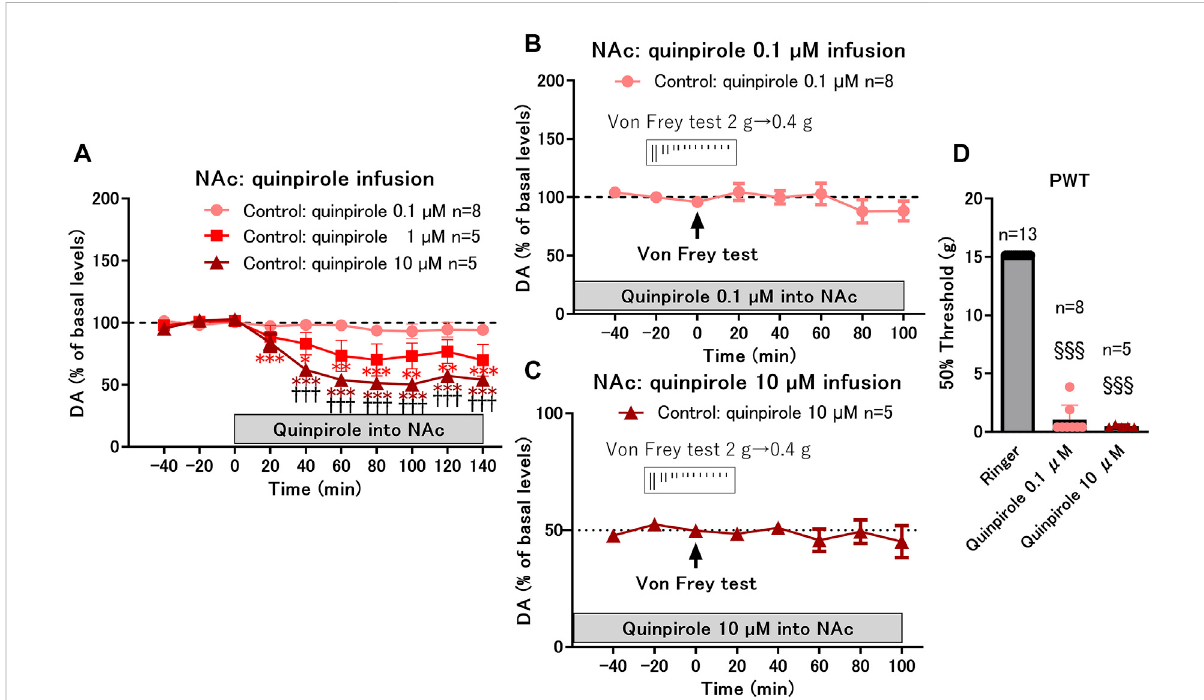
FIGURE 4 Effects of local infusion of quinpirole into the nucleus accumbens shell (NAcSh) on the paw withdrawal threshold (PWT) in control rats. (A) EffectsoflocalinfusionofaD2-likereceptoragonist,quinpirole,intotheNAcSh(0.1,1,and10 μ M)onthebasallevelsofDAinthecontrolgroup;* p < 0.05, ** p < 0.01, *** p < 0.001 versusthe basal levels ofDA inthesame group; mixedlinear models; ††† p < 0.001 between10 and 0.1 μ M groups; two- way ANOVA and Sidak ’ s multiple comparisons test. (B,C) Effects of von Frey test after 2 h of local infusion of quinpirole at a low dose (0.1 μ M) withconstantdopamine levels( − 100%ofbasal levels) (B) andatahighdose(10 μ M)with decreaseddopamine levels( − 50%ofbasal levels) (C) onDA levels; (D) Localinfusionofquinpiroleatlow(0.1 μ M)andhigh(10 μ M)dosesdrastically decreasedthePWT. §§§ p < 0.001versusthegroupwithRinger infusion; Kruskal-Wallis test and Dunnet ’ s multiple comparisons test. Data represent mean ± SEM (A – C) and mean ± SD (D) . The number of rats is indicated in the